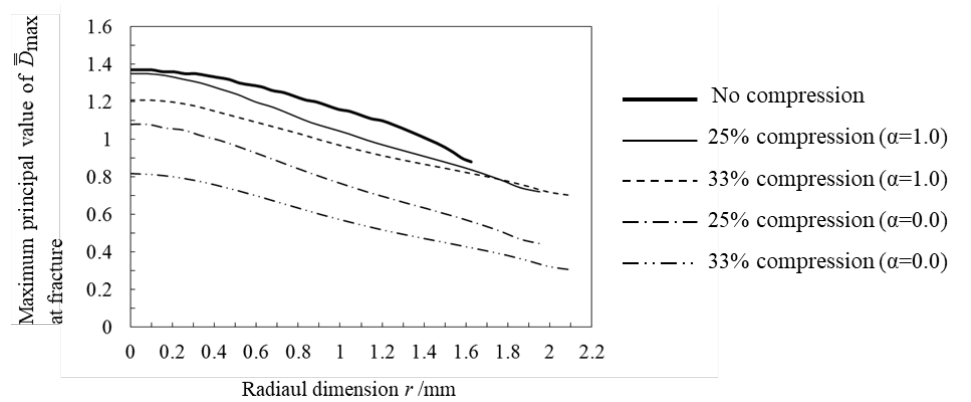
Figure 12. Change in maximum principal damage using compressed specimen (Specimen A).